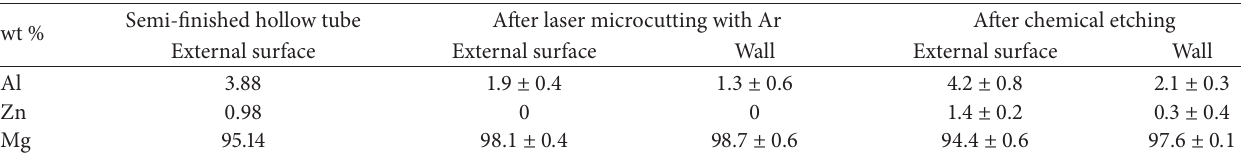
Table 4: Chemical composition of the semi-finished hollow tubes in comparison with the stents laser microcut using Ar, before and after chemical